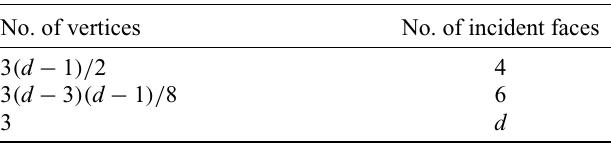
TABLE II. The lattice L 2D , which we use to define the 2D sta- bilizer color code of distance d , consists of 3 ( d 2 + 7 )/ 8 vertices, 3 ( 3 d 2 + 5 )/ 8 edges, and ( 1 + 3 d 2 )/ 4 faces. We group vertices of L 2D into three different categories depending on the number of faces incident to them. Note that qubits are placed on faces, whereas stabilizers are identified with vertices of L 2D .